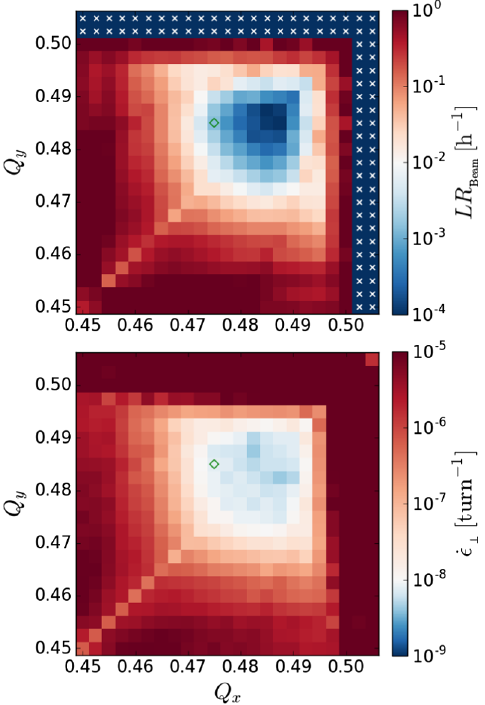
ϕ 0 . 03 , Tot ð PIW Þ ¼